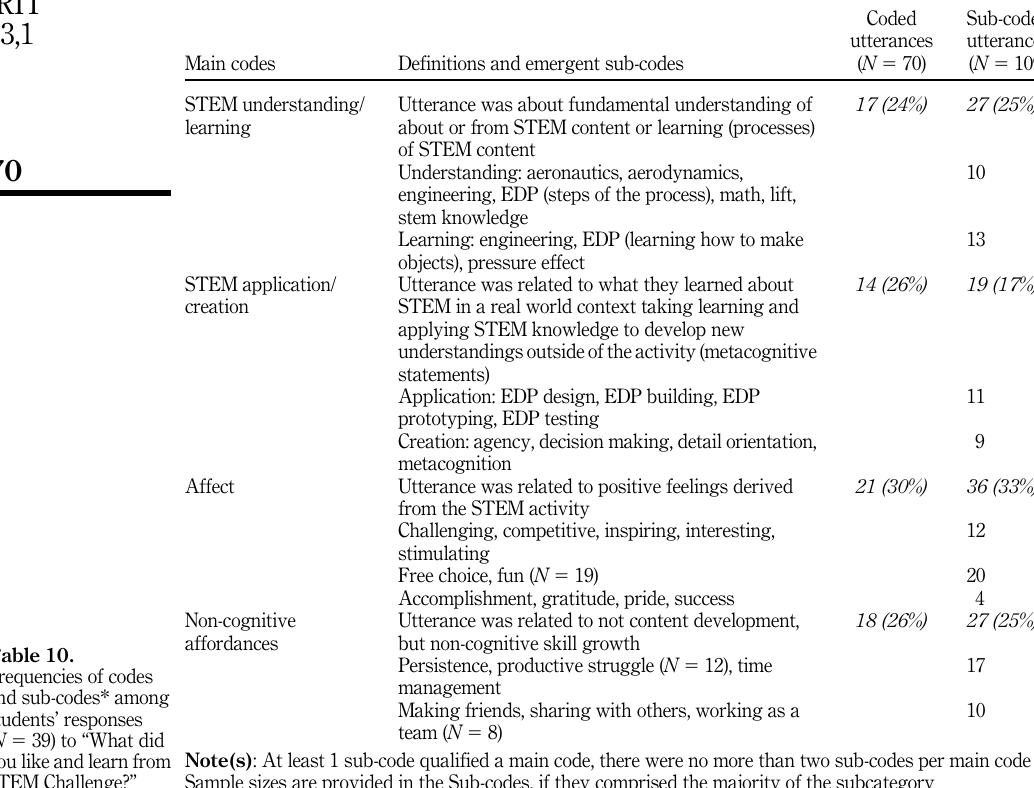
Table 10. Frequencies of codes and sub-codes* among students ’ responses ( N 5 39) to “ What did you like and learn from STEM Challenge?